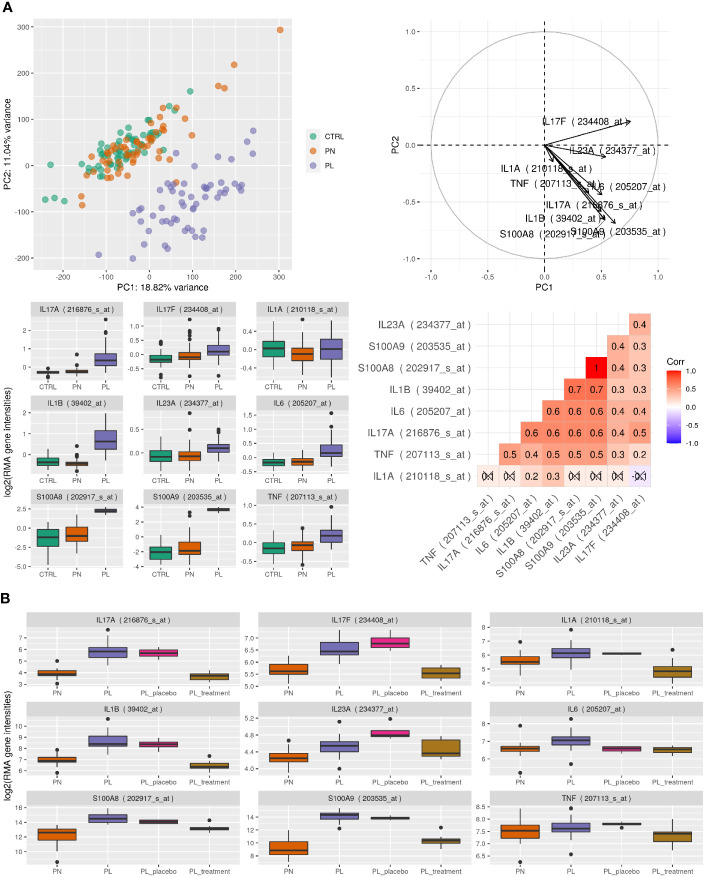
Human gene expression analysis. (A) Microarray expression data from psoriatic patients and normal controls. Top left: principle component analysis (PCA) of 180 samples with skin samples of healthy controls (CTRL, n = 64) and 58 paired samples of psoriasis patients (PN = uninvolved skin, PL = involved skin). Top right: contributions of selected gene probes toward the variance in first and second principle components from PCA. Bottom left: boxplot of selected gene probes in the separate groups. Bottom right: Spearman correlation coefficient of expression between selected gene probes, where correlations were crossed out if they were not found to be significant with p <0.05. Data taken from GEO accession ID GSE13355. (B) Microarray expression data from psoriatic patients during IL-17 directed treatment. The different groups represent 25 patients with lesional (PL) and non-lesional (PN) skin. Additionally, biopsies were taken of lesional skin after 43 days of placebo (PL_placebo) or 700 mg of brodalumab treatment (PL_treatment). Data were taken from GEO accession ID GSE53552.Boxplot of selected gene probes based on expression data run on Affymetrix HU133 Plus 2.0 microarrays.